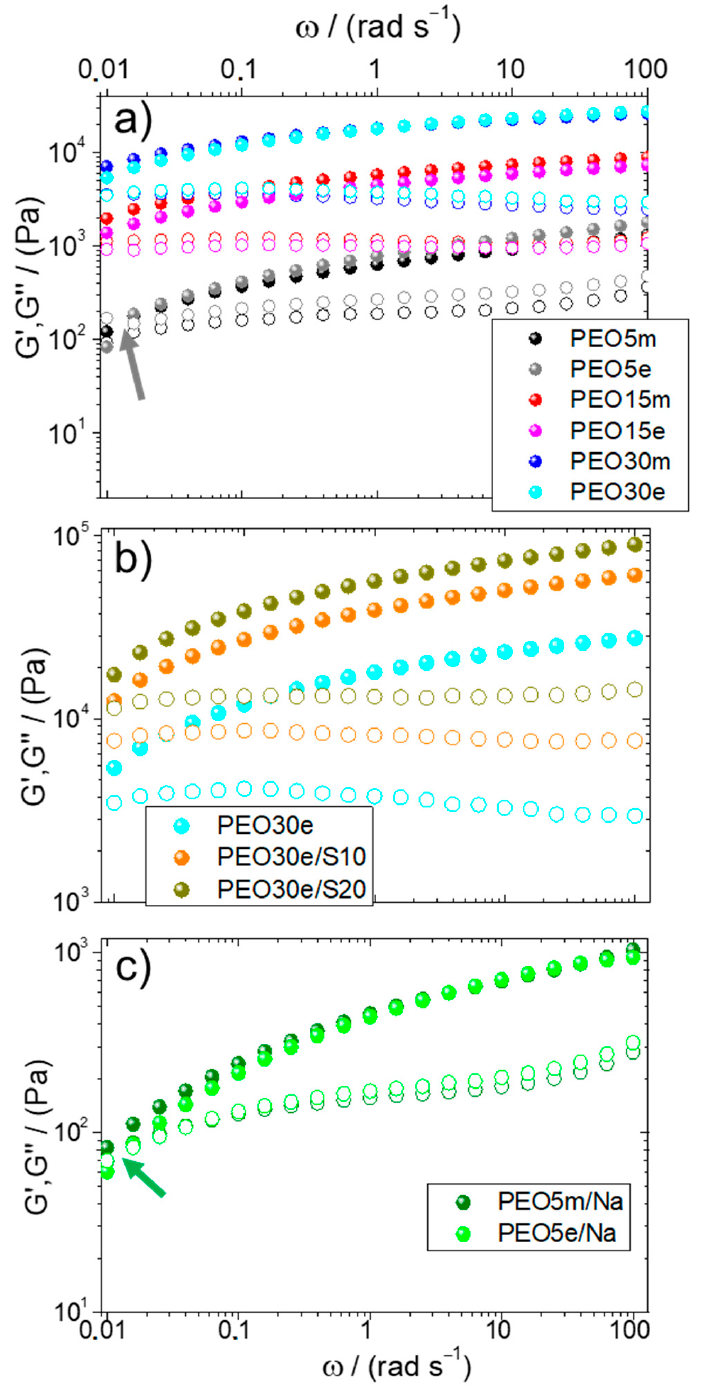
Figure 2. Rheology curves of all the electrolytes at 75 °C: ( a ) Li electrolytes; ( b ) P30e series; ( c ) Na electrolytes. Solid symbols: G ′ , open symbols: G ″ . Arrows indicate the crossover frequencies.